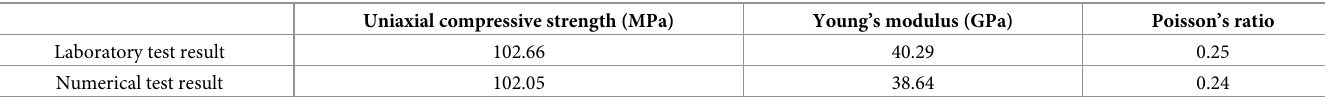
Table 1. Comparisons of the basic mechanical parameters of the granite